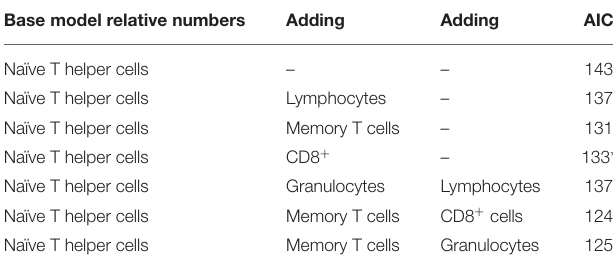
TABLE 7 | Multivariable approach results with relative numbers of different white blood